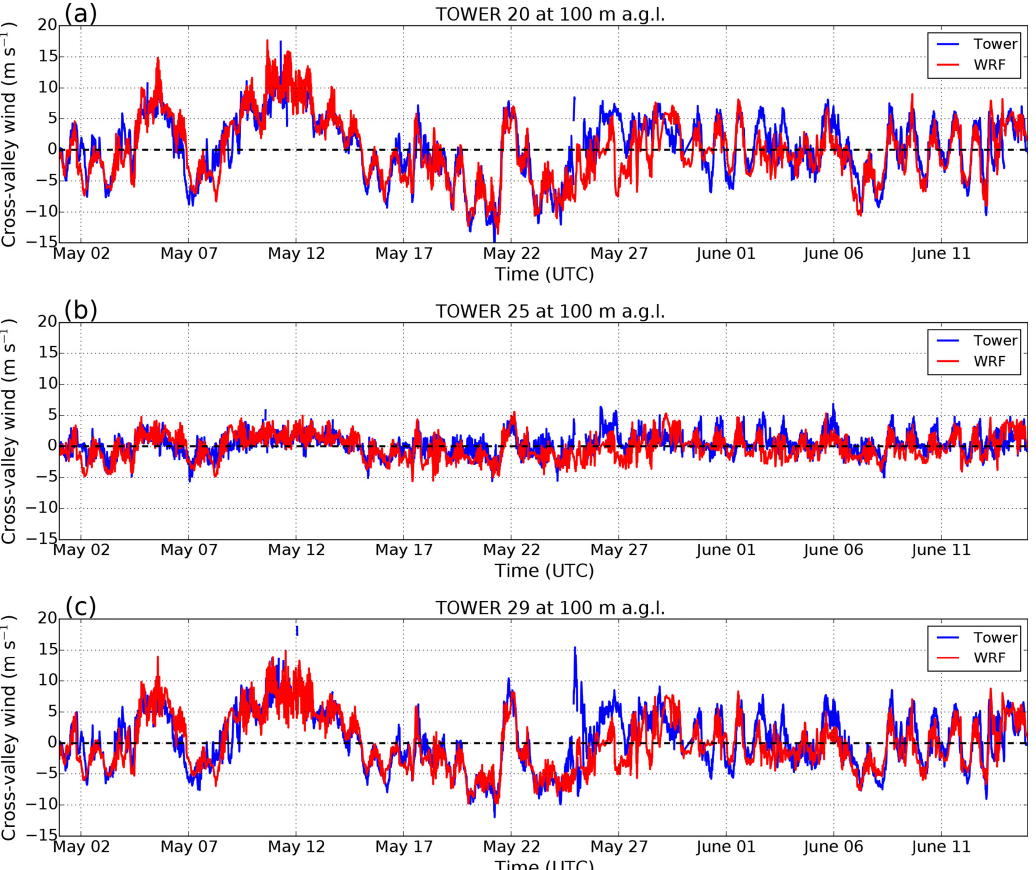
Figure 5. Time series of observed and simulated (WRF D3) cross-valley wind at 100ma.g.l. for (a–c) towers T20, T25 and T29 (see Fig. 1c for tower locations). Table 2. Correlation coefficient (COR) and root mean square error (RMSE) values for the comparison of WRF data with observations at towers T20, T25 and T29. Values for cross- (along-)valley winds are written in bold (normal) font. T20 T25 T29 Domain COR RMSE (ms − 1